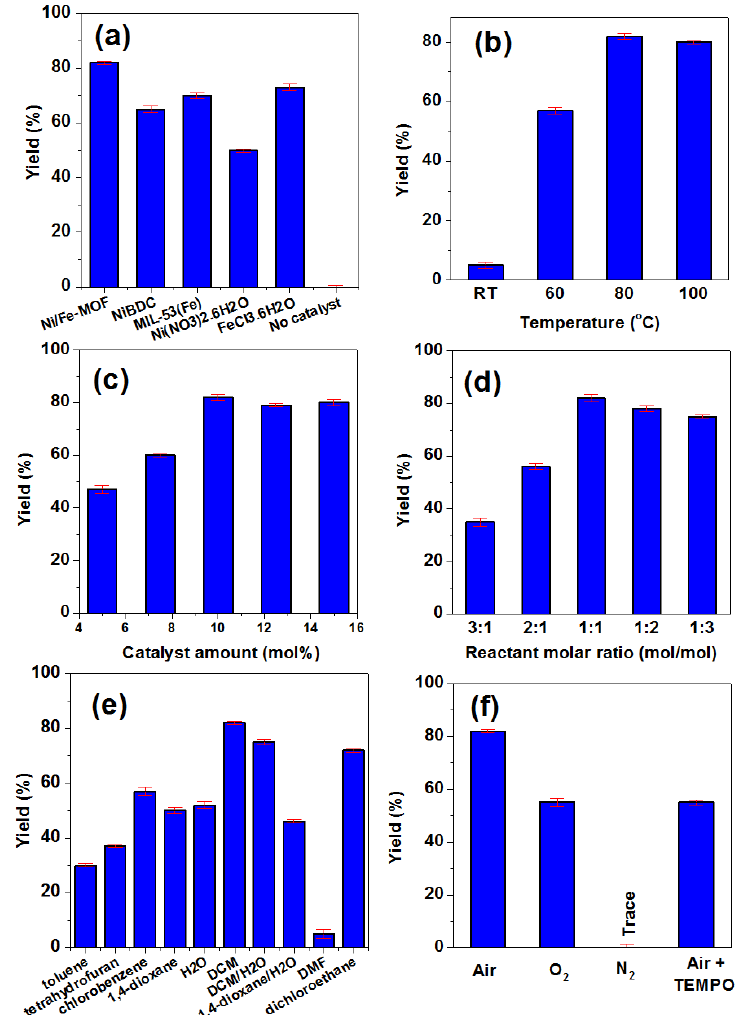
Figure 5. The yield of N-pyridinyl benzamide vs. catalyst ( a ), temperature ( b ), catalyst amount ( c ), reaction molar ratio ( d ), solvents ( e ), and yield of N-pyridinyl benzamide under air, O 2 , N 2 , and air + 2,2,6,6-Tetramethyl-1-piperidinyloxy (TEMPO) ( f ).